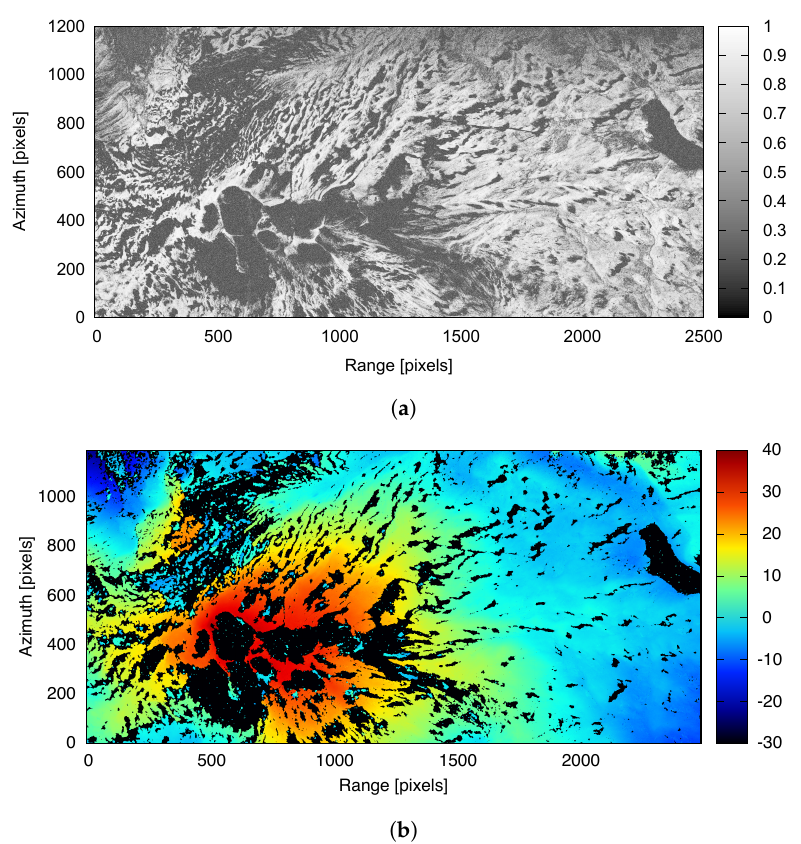
Figure 3. ( a ) coherence image of the test pair over the Copahue volcano. ( b ) fully connected unwrapped phase. Color chart values are given in